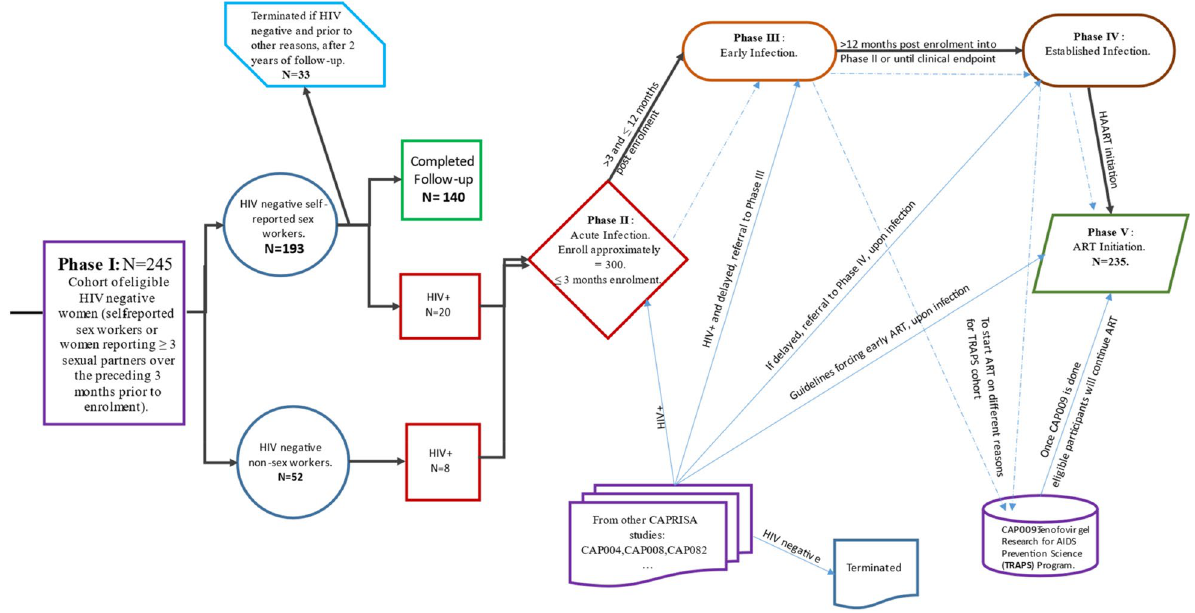
Figure 1. Diagrammatic overview of the CAPRISA 002 AI cohort study